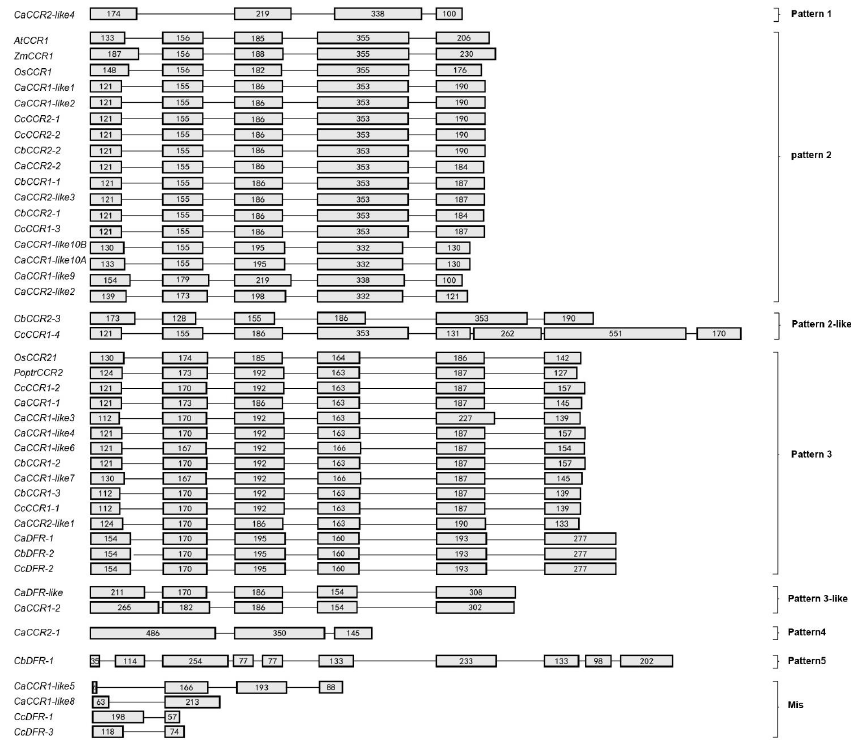
Figure 1. Exon–intron structures of pepper CCRs and other plant CCR genes. Pepper CCRs and other plant CCRs were divided into seven patterns based on their exon–intron structures. Exons and introns are indicated by boxes and lines, respectively. Numbers in the boxes represent the exon sizes. The intron sizes are not to scale. The pattern names of exon–intron structures are indicated in on the right side of the figure. A. thaliana CCR (AtCCR) , Z. mays CCR (ZmCCR) , O. sativa CCR (OsCCR) , and Populus trichocarpa CCR (PoptrCCR)